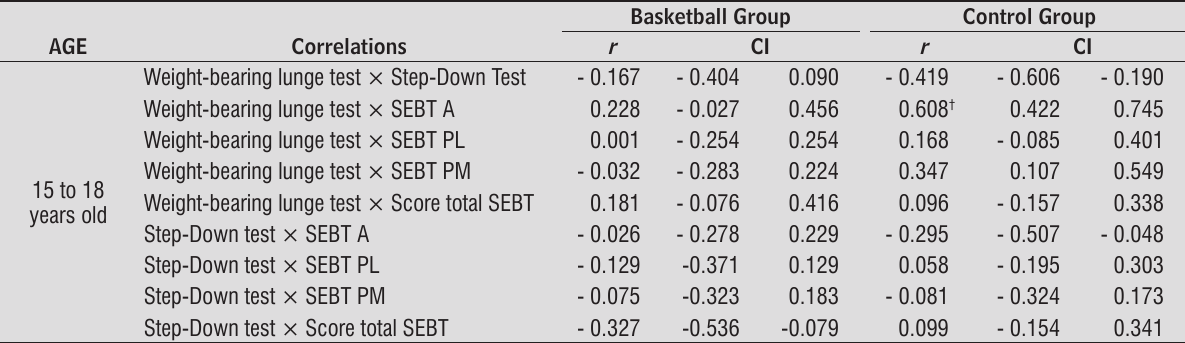
Table 3 - Pearson’s correlation coefficient for basketball and control groups according to age Basketball Group Control